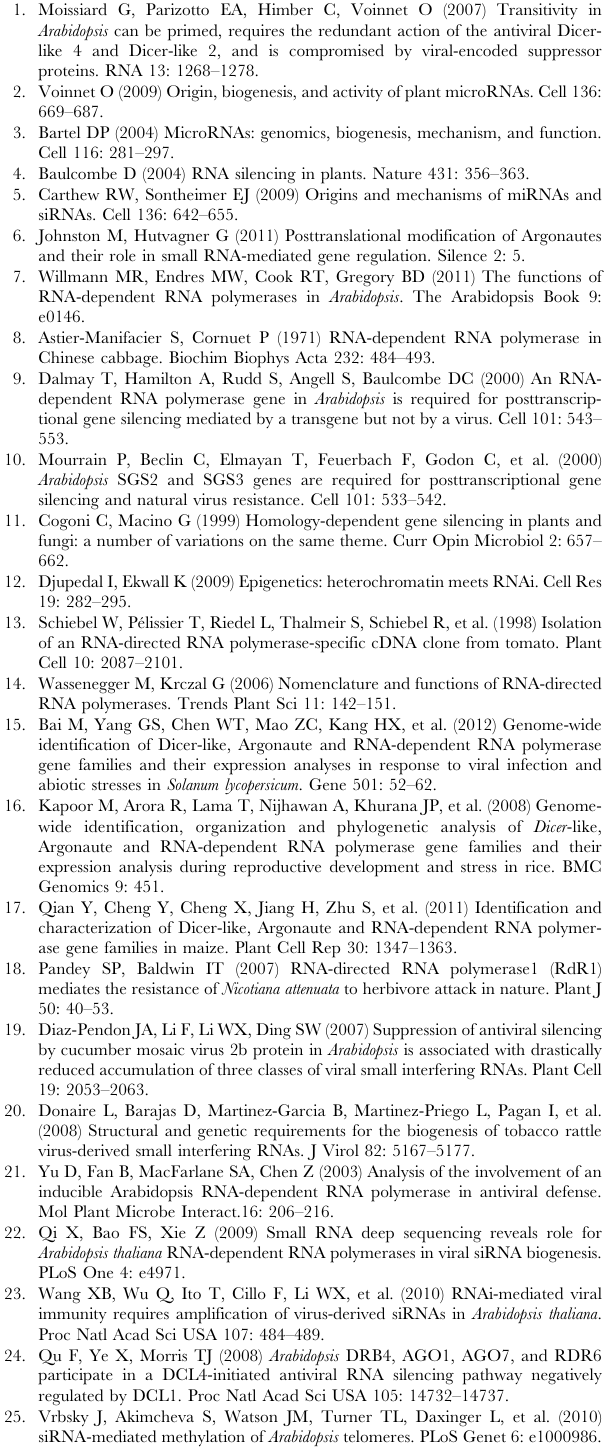
Table S4 Primers used for